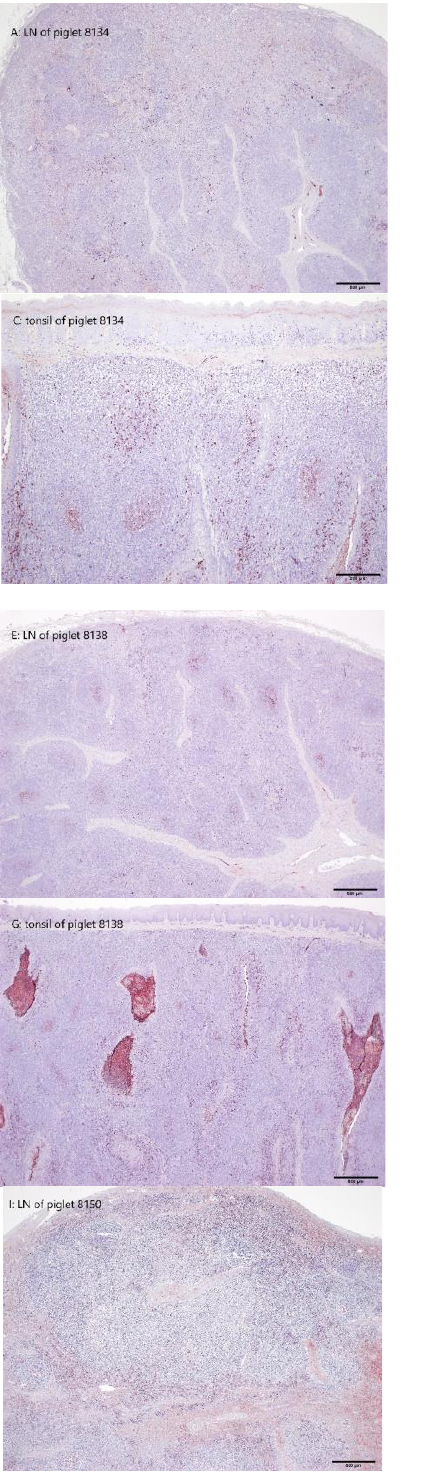
Figure 6. CSFV antigens in the lymphoid tissues were marked by the 1C7A1 monoclonal antibody. A lymph node ( A , B ) and tonsil ( C , D ) of Piglet 8134 (Group 2), which had transient TD/96 viremia, present the brown TD/96-positive signal. A lymph node ( E , F ) and tonsil ( G , H ) of Piglet 8138 (Group 3), which had transient TD/96 viremia, present the brown TD/96-positive signal. A lymph node ( I ) of Piglet 8150 (Group 1) presents a diffuse brown TD/96-positive signal in the paracortex. A lymph node ( J ) of Piglet 8146 (Group 4) was negative for TD/96.